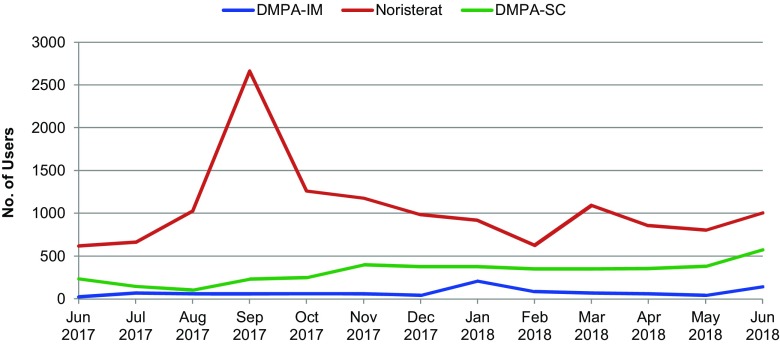
Number of Users of Injectables at the Facility Level, by MethodAbbreviations: DMPA-IM, DMPA-SC, intramuscular depot medroxyprogesterone acetate; DMPA-SC, subcutaneous depot medroxyprogesterone acetate.